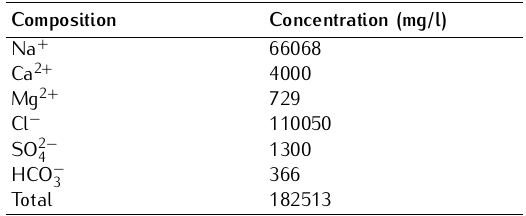
Table 3. Ion analysis of aquifer used in this